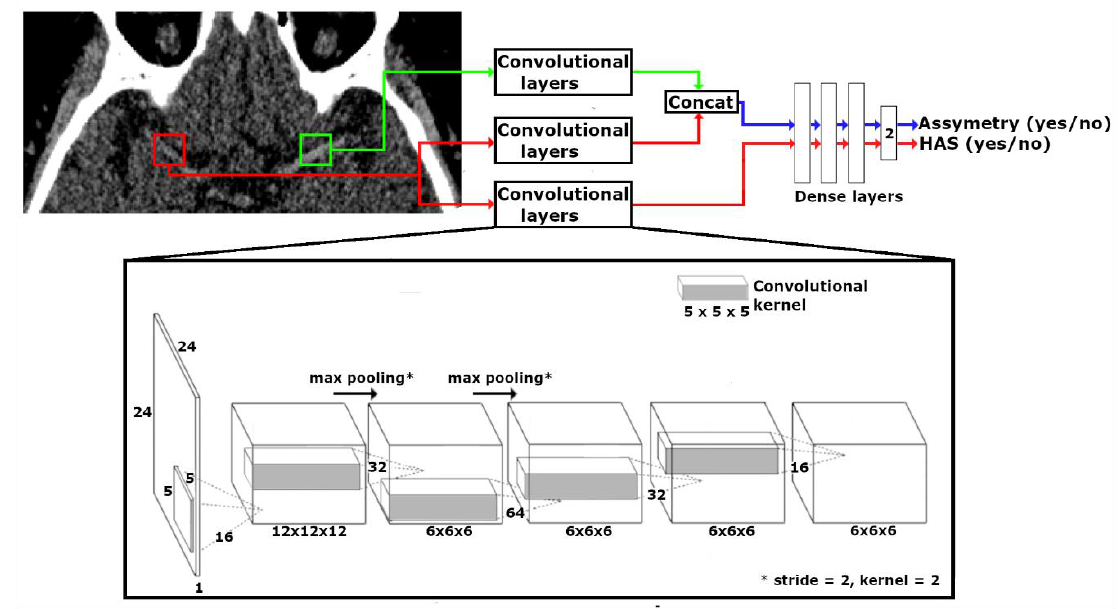
Figure 1. Convolutional neural networks (CNN) architectures for the asymmetry and hyperdense artery sign (HAS) detection network. Both networks have similar architectures. The convolutional layers consist of 5 convolutional layers with max pool layers after the first two convolutions. The asymmetry detection network concatenates the output of the convolutional layer from left and right patch pair, before passing through the dense layers. Dimensions of the feature maps and convolutional kernels are shown at the borders. The number of filters is shown at the forward pass for each convolutional kernel. 2.4. Ground